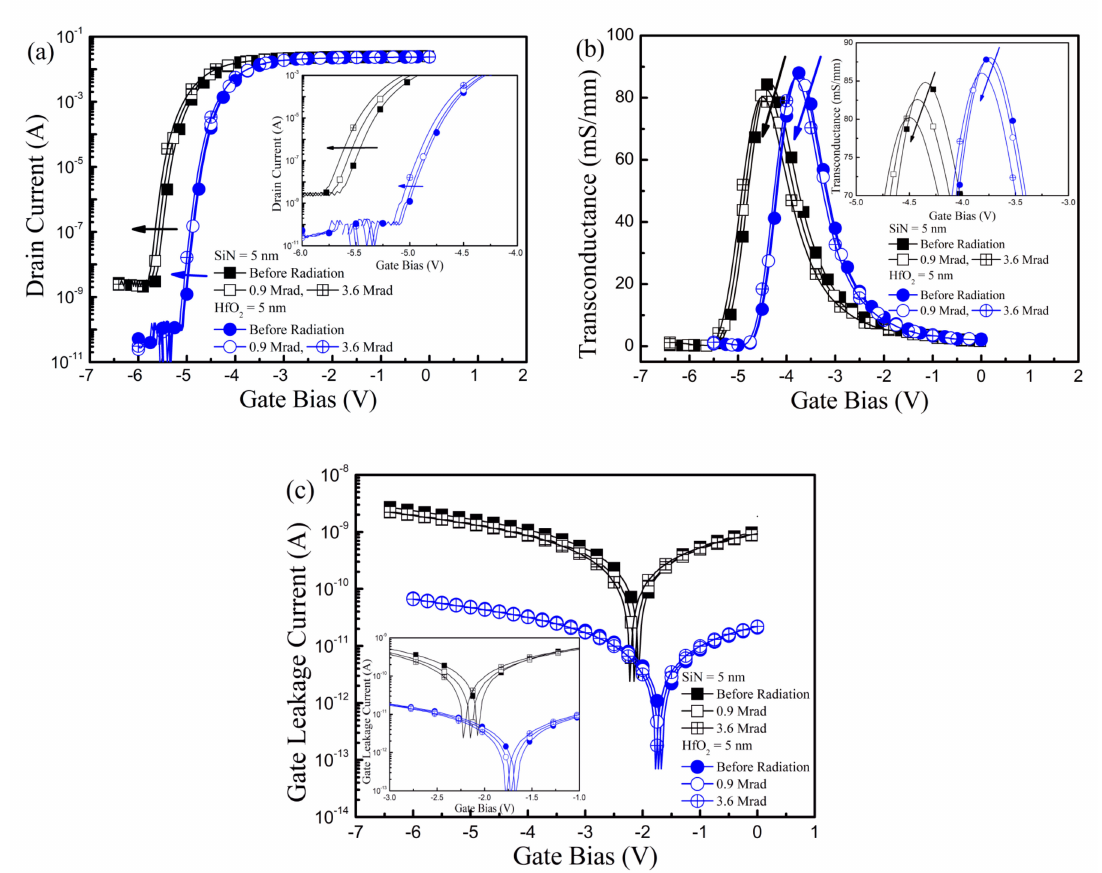
Figure 2. Transfer characteristics of the GaN-based MIS-HEMTs for a 5 nm-thick SiN and HfO 2 gate dielectric layer before and after γ -ray radiation with the doses of 0.9 and 3.6 Mrad. ( a ) Drain current; ( b ) transconductance; ( c ) gate leakage current as a function of gate bias. Inset in Figure 2a–c shows the zoomed-in drain current at the subthreshold regime, transconductance near the transconductance maximum, and gate leakage current near the gate leakage minimum,